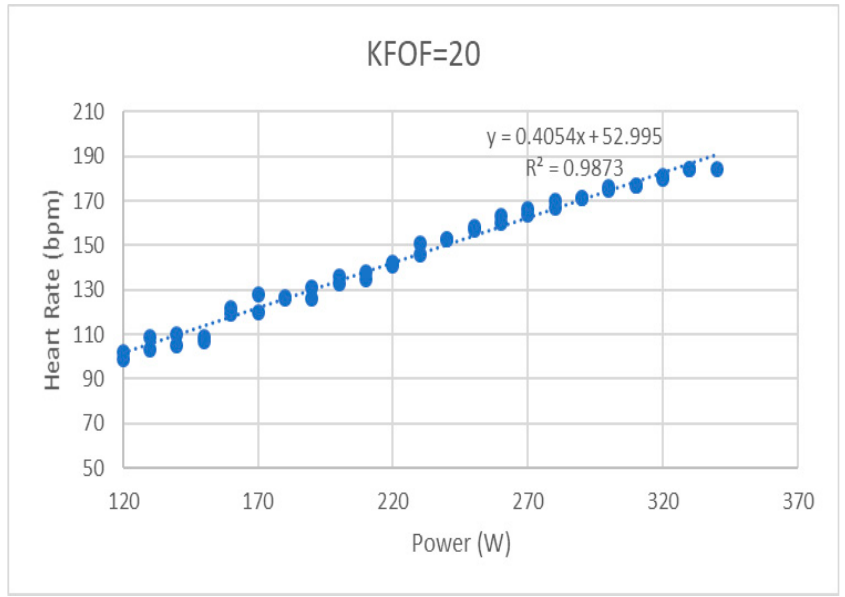
Figure 2. An example of a regression line of the heart rate with KFOF at 20 mm position.